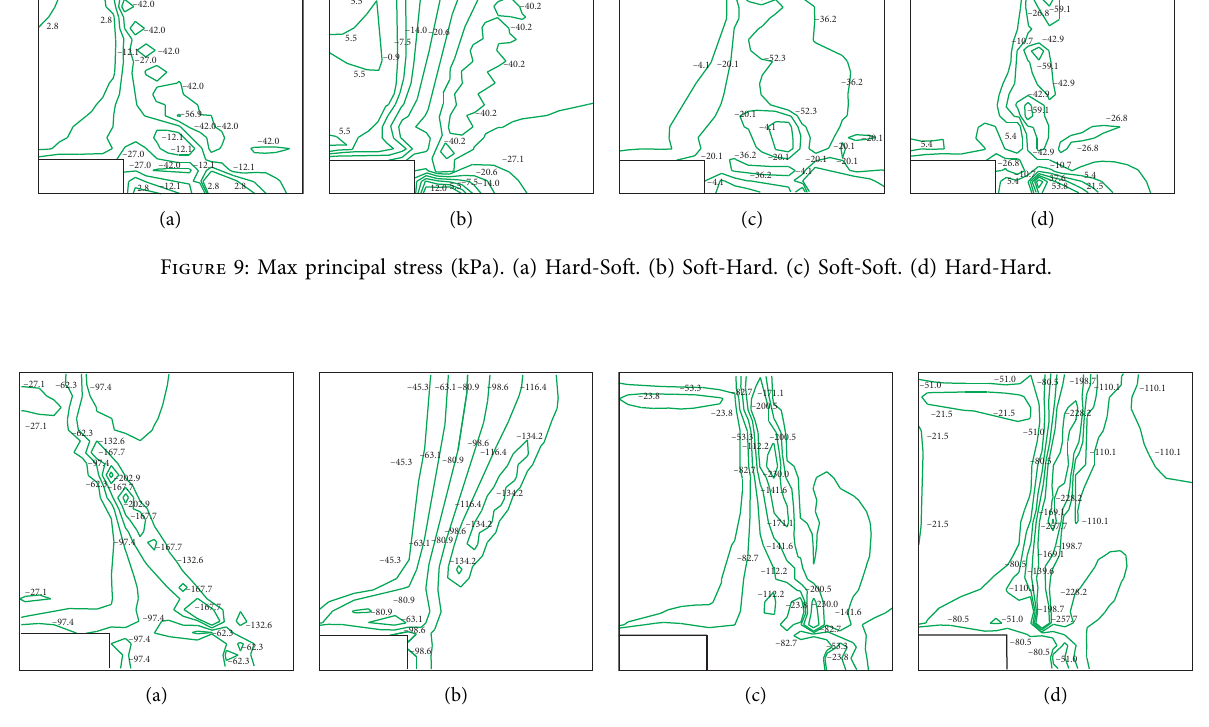
Figure 10: Min principal stress (kPa). (a) Hard-Soft. (b) Soft-Hard. (c) Soft-Soft. (d)